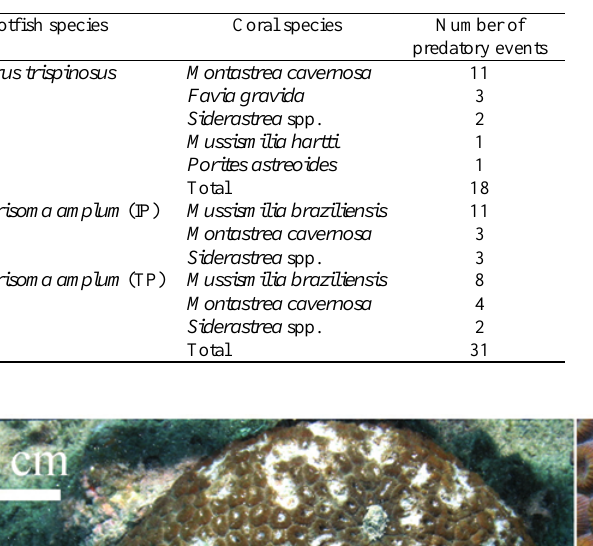
Table 1. Opportunistic records of live coral predation by Scarus trispinosus and Sparisoma amplum in the Abrolhos Bank, eastern Brazil. IP - initial phase and TP - terminal phase